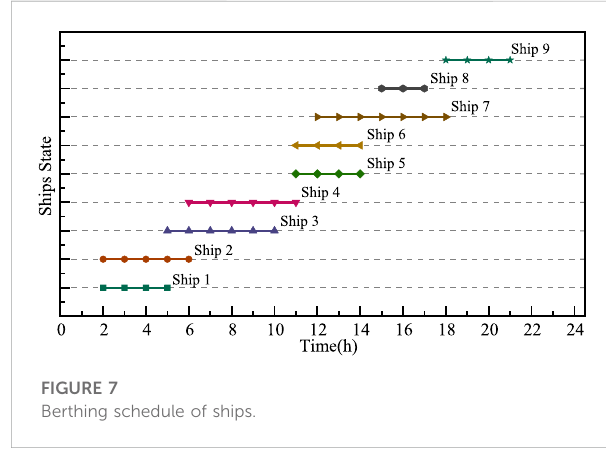
FIGURE 7 Berthing schedule of ships.